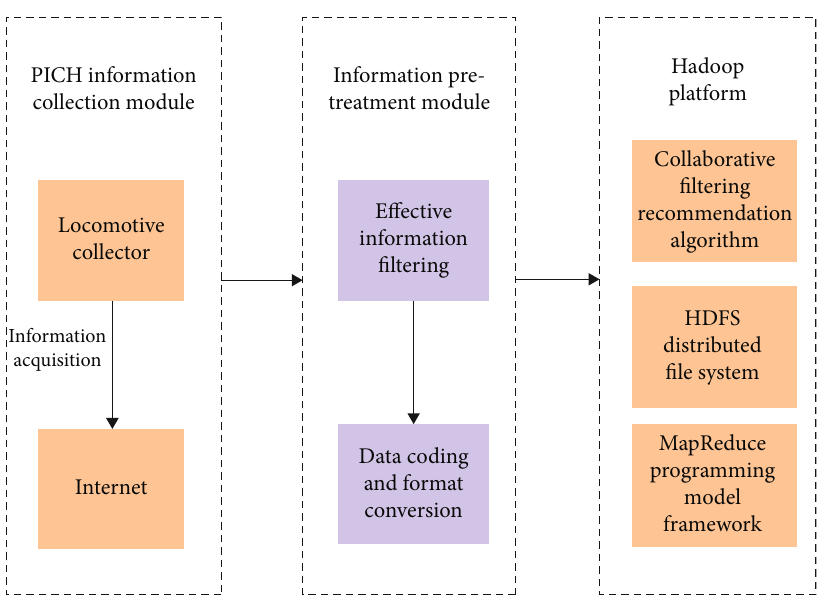
Figure 4: PICH recommendation system